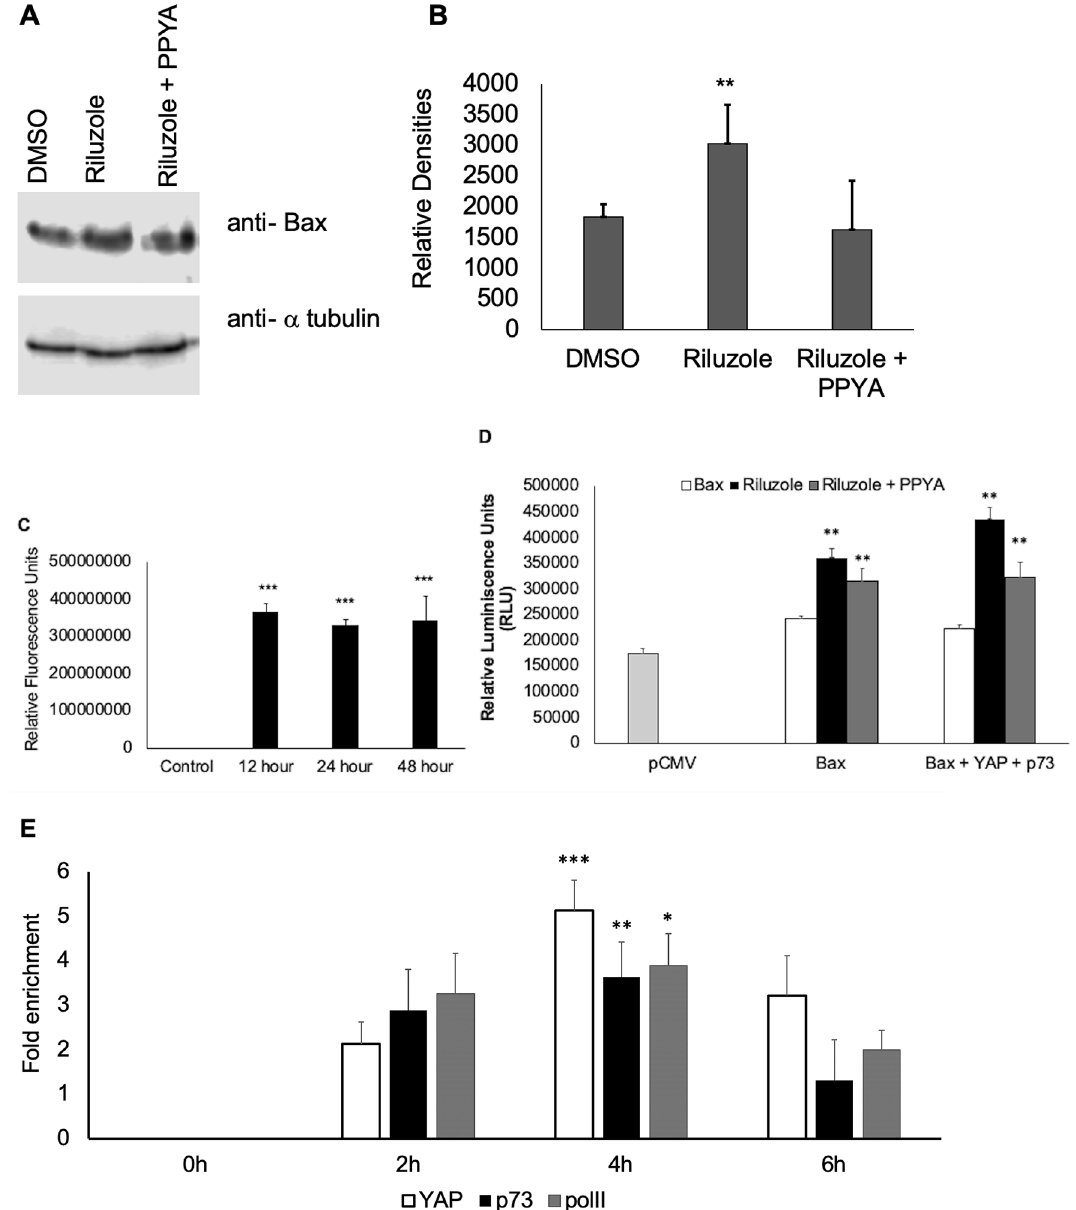
Figure 6. Riluzole enhances Bax expression by inducing Bax promoter activity in LM7 cells. ( A ) Whole cell extracts from LM7 cells were probed with anti-Bax antibody to determine the effect of Riluzole (50 μM) and Riluzole (50 μM) + PPY A (20 nM) on Bax expression, α tubulin is used as a loading control. ( B ) Bar graph showing densities of bands from 3 independent experiments. ( C ) Caspase assay represents data from 3 independent experiments, p value = 0.003***. ( D ) Bax promoter driven luciferase expression was measured in LM7 cells. LM7 cells were treated with DMSO or Riluzole (50 μM) or Riluzole (50 μM) + PPY A (20 nM) for 24 h, p value < 0.05**. ( E ) Fold enhancement of the Bax promoter activity was measured using Chromatin Immunoprecipitation assay using anti YAP, anti p73 and or Polymerase II antibodies followed by qPCR to detect and quantify fold induction of Bax promoter. Representative data of three independent experiments is shown, p value < 0.5* p value < 0.05**. p value < cytoplasm and phosphorylation at serine 381 is shown to promote ubiquitin mediated degradation of YAP 34,38,55 . The 5SYAP mutant used in our localization studies included mutations of serine at 127 and 397 demonstrating that these residues are not important for YAP localization to nucleus, prompting the involvement of phosphoryla- tion of residues other than the 5 mutated serine residues (serine 61, 109, 127, 164, and 397). Based on our data, we believe that nuclear localization of YAP was facilitated by changes in phosphorylation, both by a decrease in S127 phosphorylation and an increase in Y357 phosphorylation. This effectively promoted association of YAP with p73 to activate pro-apoptotic genes.